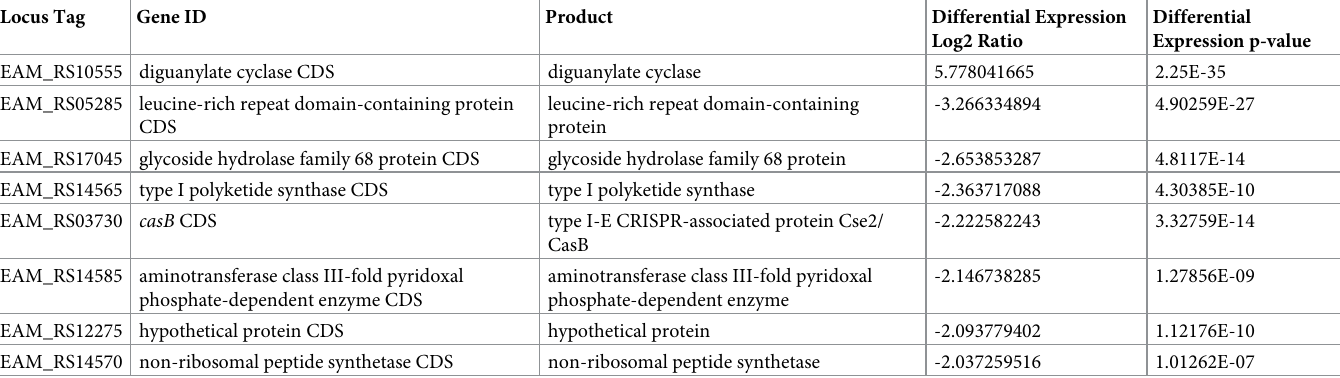
lower intracellular levels of c-di-GMP. A similar co-dependence on both the flagellum and the pilus for surface attachment has been demonstrated in P . aeruginosa , wherein, upon first sur- face contact by the flagellar filament, the rotational changes sensed by the motor proteins MotAB result in a rapid increase in c-di-GMP levels which can bind to the effector FimW and Table 6. A list of the statistically significant differentially regulated genes (Log2 fold change of two) in Ea1189 Δ 8+e dcD OE relative to Ea1189 Δ 8. Locus